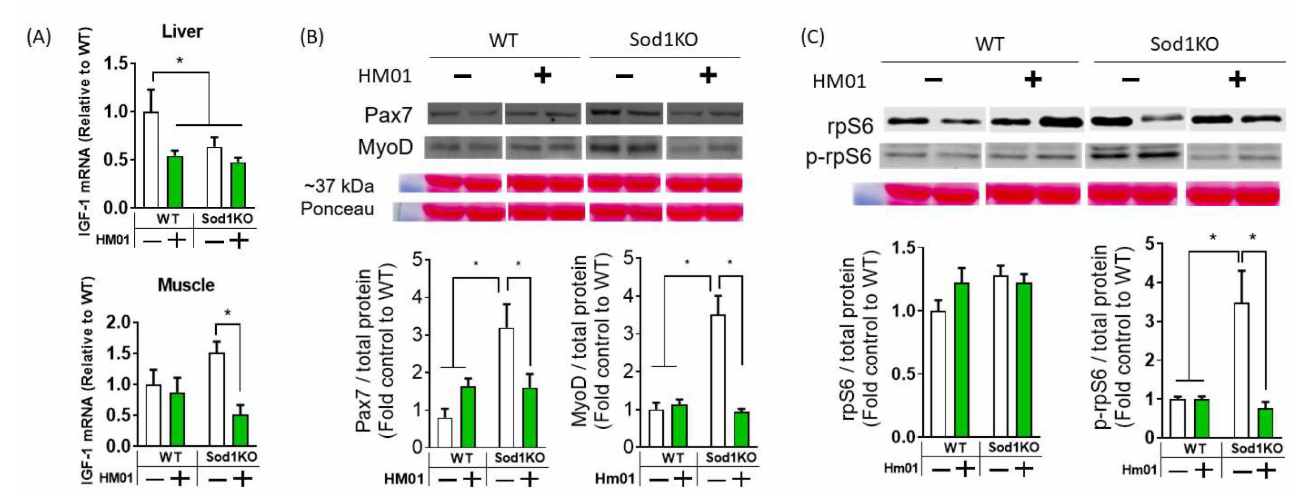
Figure 3. Four-week HM01 treatment abrogates anabolic pathways in Sod1KO. ( A ) IGF-1 levels in the liver and muscle are significantly decreased after HM01 treatment. ( B ) Proteins involved in myogene- sis, Pax7 and MyoD, are upregulated in Sod1KO muscle. This upregulation is abrogated by HM01 treated Sod1KO group. ( C ) Ribosomal protein S6 levels were unchanged, but its phosphorylation is significantly upregulated at Ser240/244 sites. HM01 treated mice are lacking this upregulation of the marker for ribosomal protein synthesis. Two-Way ANOVAs were used to test statistical significance between groups, followed by Tukey post hoc tests. Data are mean ± SEM. * p < 0.05.